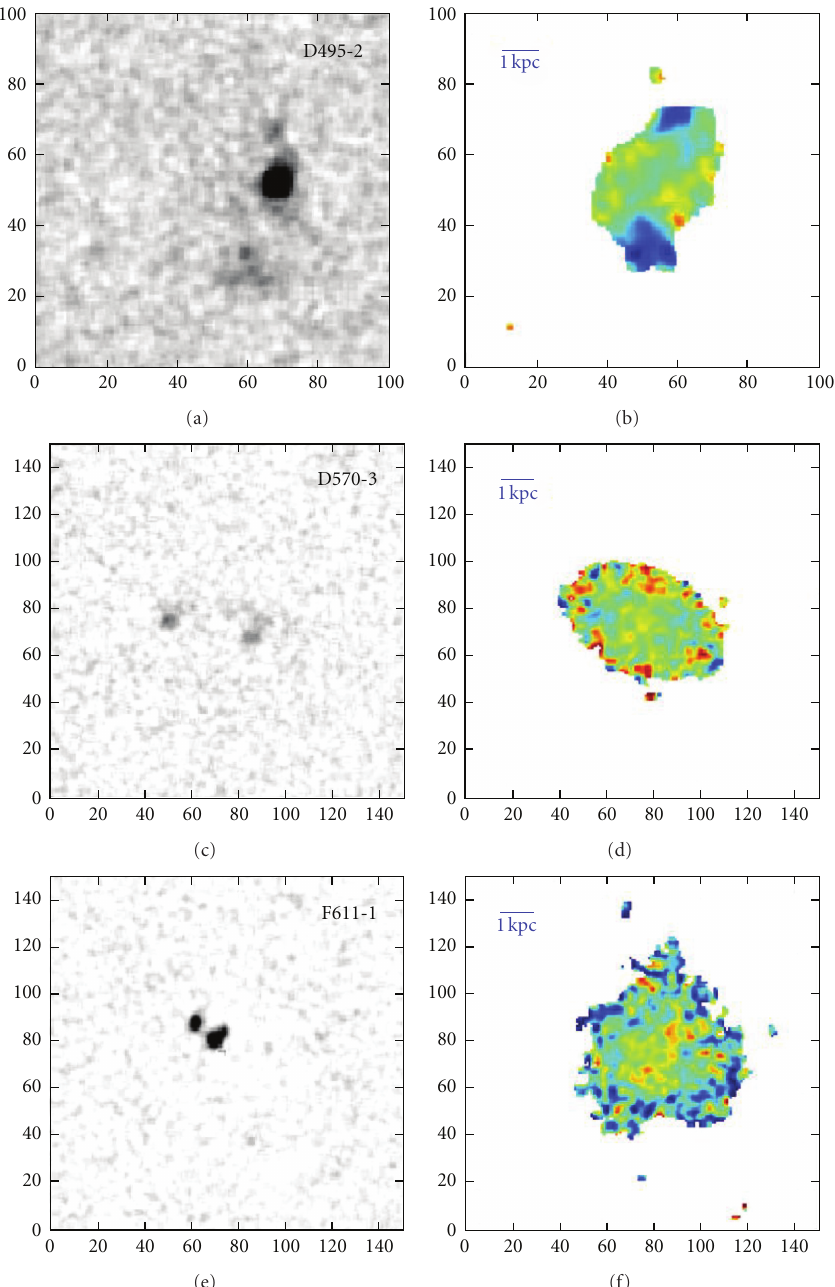
Figure 15: Three LSB galaxies viewed for their H α emission (left panel) and their B − V color maps (right panel, B − V = 0 . 0 is blue, B − V = 1 . 0 is red). There are no prominent correlations with spatial color and H α